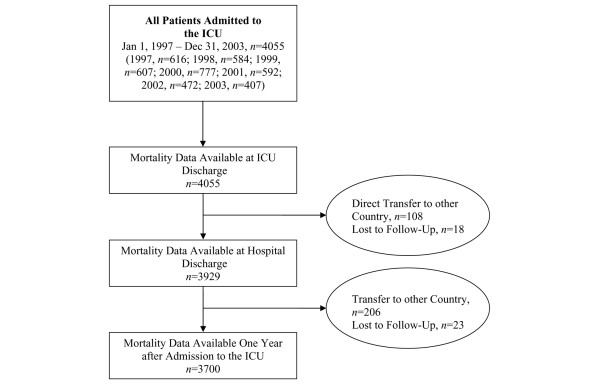
Overview of data inclusion. ICU, intensive care unit.